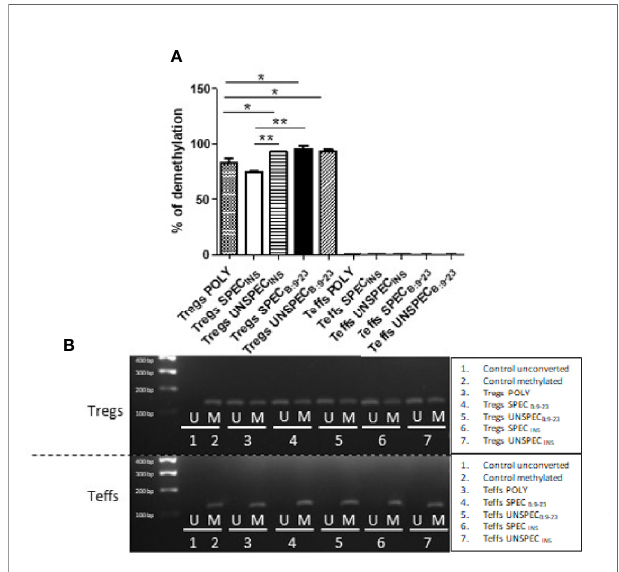
FIGURE 5 | FoxP3 demethylation in TSDR region in Tregs and Teffs. (A) Comparison of percentage of demethylation in Treg-speci fi c demethylated region (TSDR) in Tregs: POLY, SPEC, UNSPEC and Teffs: POLY, SPEC, UNSPEC. (B) Representative results showing FoxP3 demethylation in all cell cultures was detected by agarose gel electrophoresis [reaction with methylated (M) and unmethylated (U) primer]. During the tests cells were stimulated with anti-CD3/anti-CD28 beads (index POLY) or monocytes loaded with whole insulin (index INS) or insulin b chain peptide 9-23 (index B:9-23). Cells responding to the antigen have an index SPEC, cells not recognizing presented antigen have an index UNSPEC. All analyzes were performed for six tests (three tests for whole insulin and three tests for insulin b chain peptide 9-23) in triplicate. The results are presented as mean+/- SD. Signi fi cance was calculated using the t- test, signi fi cant results are marked with *(p<0.05), **(p<0.01) or